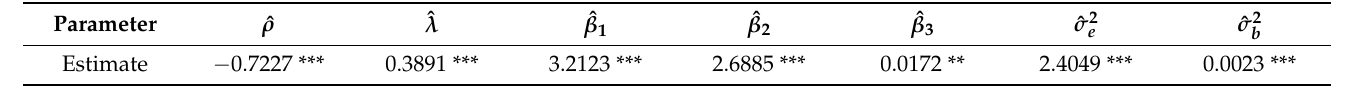
Table 10. Results of parametric estimates of model (1)–(3) for fitting Indonesia rice farming